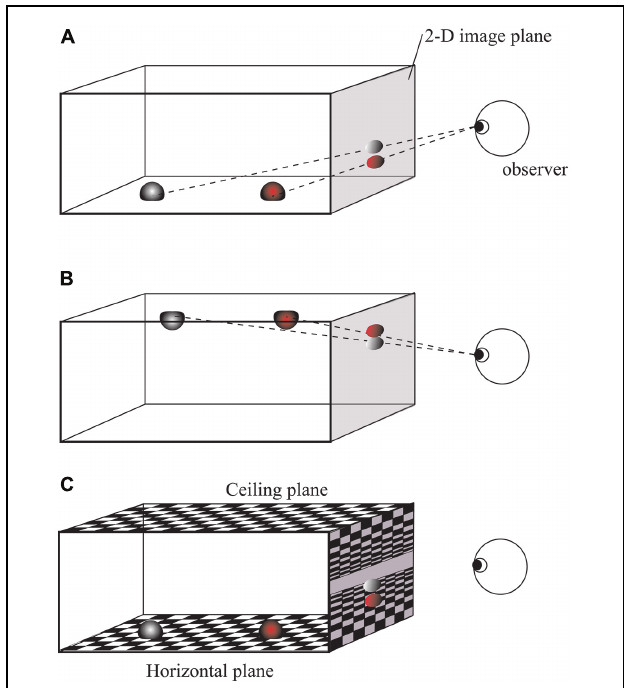
FIGURE 2 | Illustration of the relationship between 2-D vertical position and 3-D depth caused by the perspective effect. (A) Two objects have different heights on the 2-D image due to their difference in 3-D horizontal distance (depth). (B) When two objects are placed on the ceiling, the farther object is lower on the 2-D image. (C) Textured ground gives a strong impression that the two objects are at the same height in 3-D